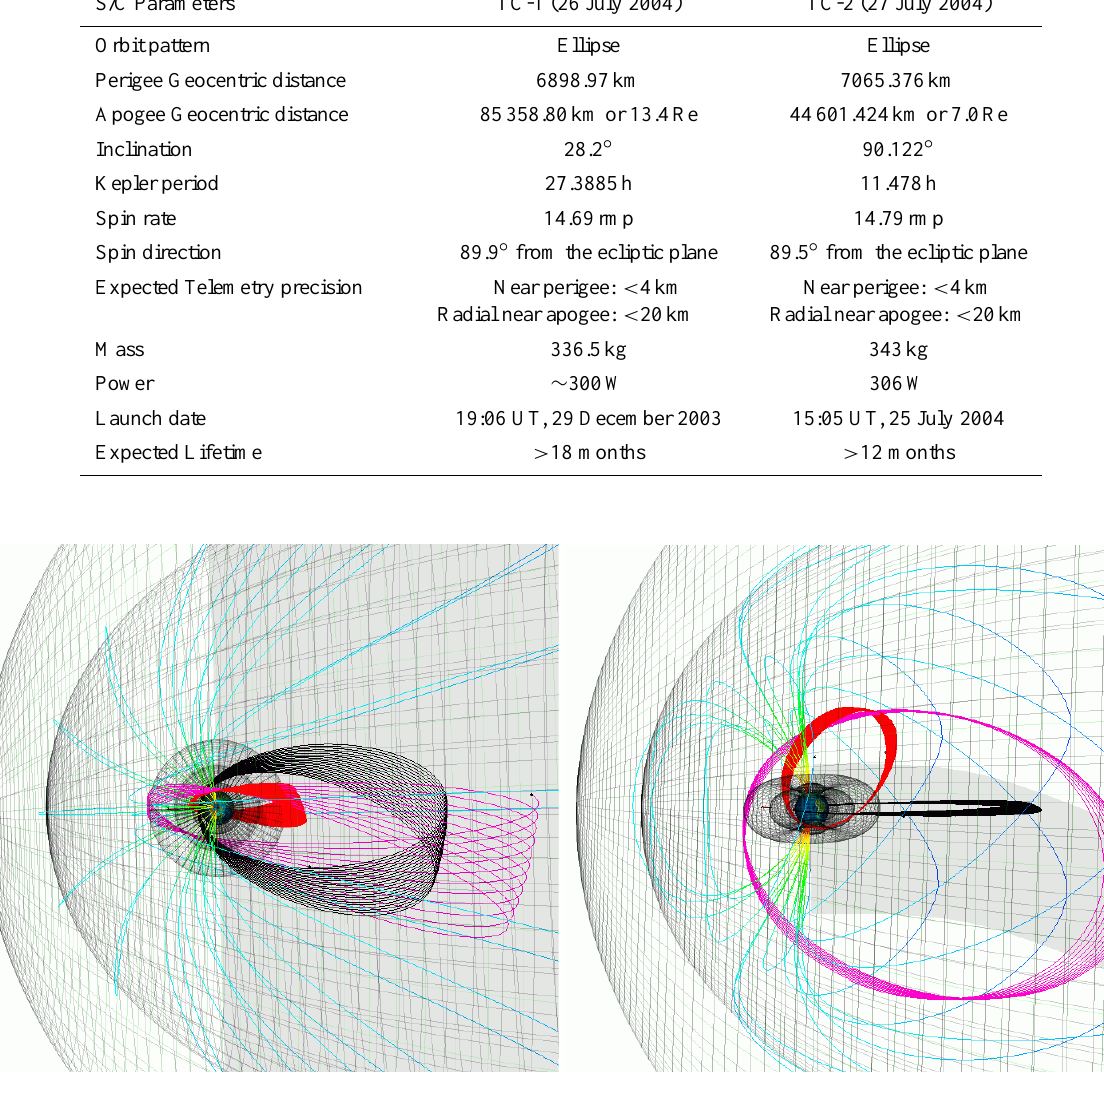
Fig. 1. TC-1, TC-2 and Cluster orbits in GSE during 1–20 September 2004 viewed from the +Z (left panel) and +Y directions (right